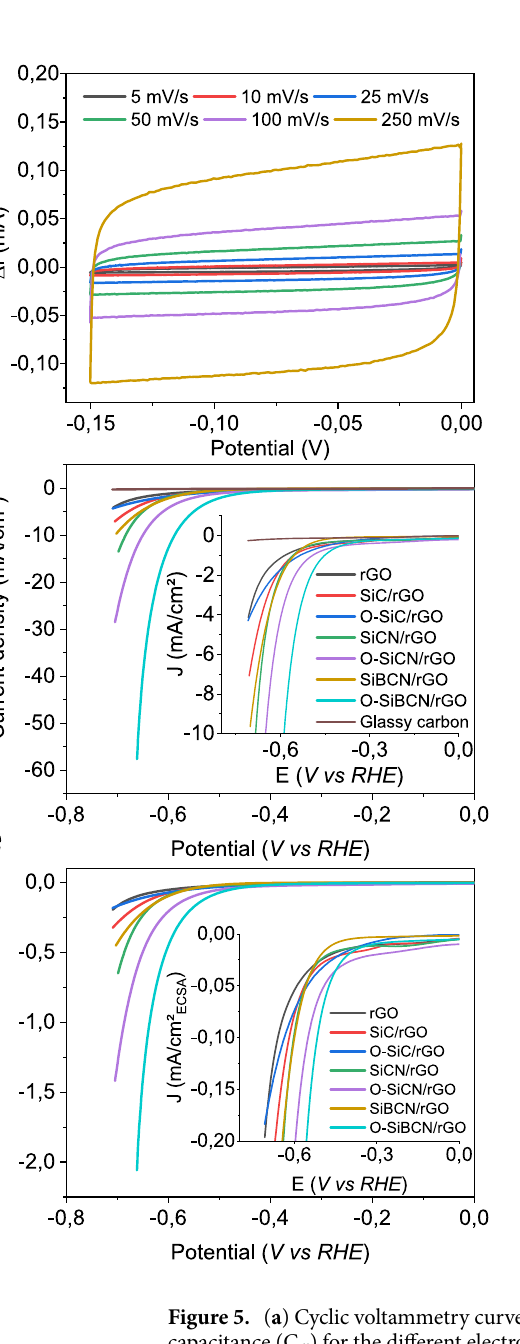
up to 1200 °C but then lose most of the activity at 1400 °C and above. To elucidate the origin of the activity loss, the PDCs were characterized using X-ray diffraction and the PDC/rGO composites using Raman spectroscopy. Both O-SiBCN and O-SiCN ceramics progressively crystallize at temperature higher than 1200 °C as shown by the rise of the peaks at 35.7° (111), 60.3° (220) and 71.25° (311) corresponding to the formation of nanosized β-SiC crystals (Fig. 6c,d). These peaks are more obvious in the case of O-SiCN (Fig. 6d). This is attributed to the presence of boron within the ceramic that delays the crystallization of Si–B–C–N systems compared to Si–C–N ones. The incapacity of Si 3 N 4 to react with free carbon via the carboreduction reaction: Si 3 N 4 + 3C → SiC + 2N 2 primarily induces the crystallization into β-Si